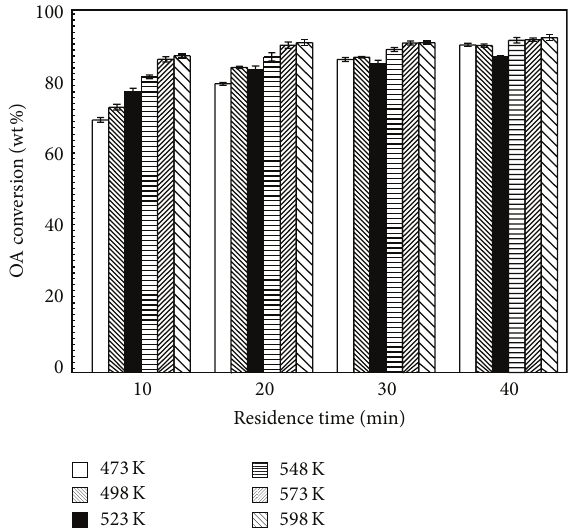
Figure 3: Effect of temperature on the conversion of oleic acid in molar ratio 1 :6 and a pressure of 20